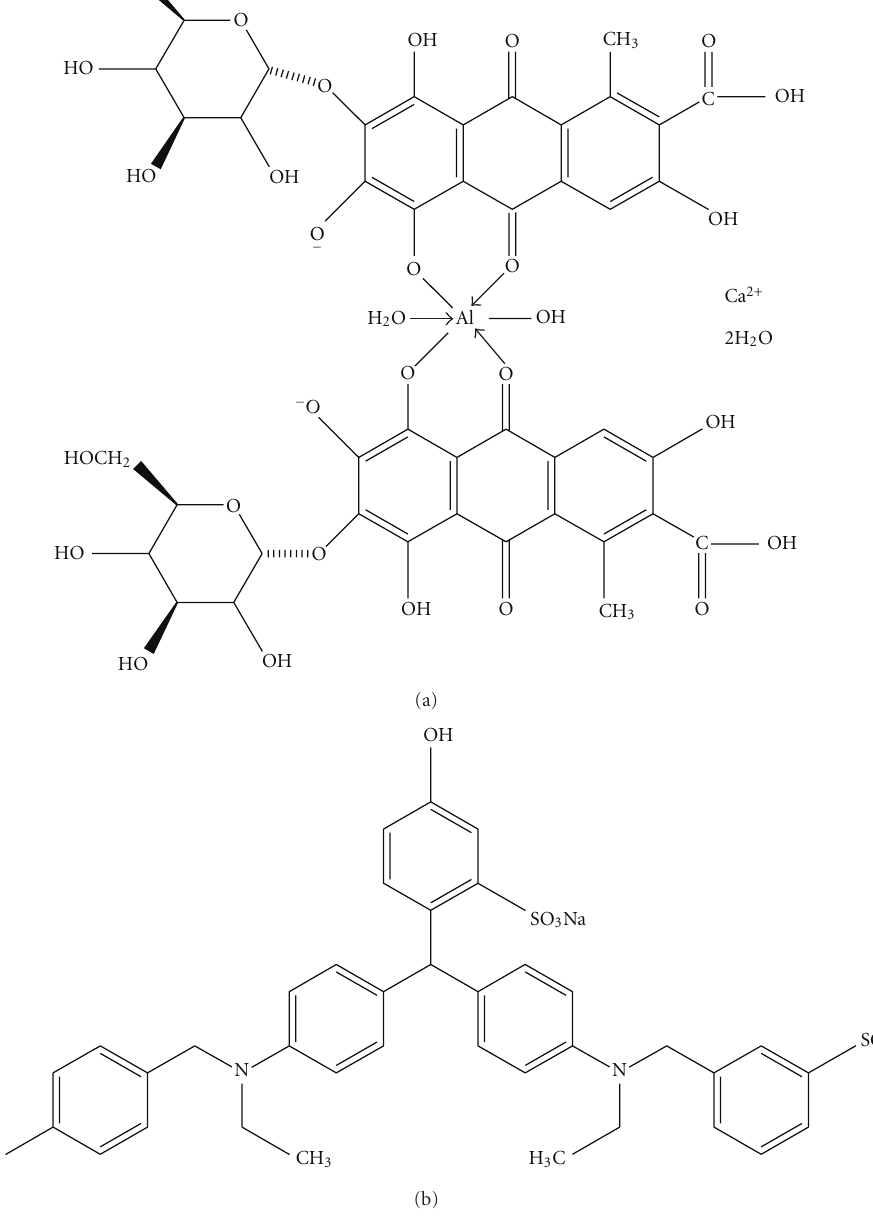
Figure 3: Structure of (a) carmine and (b) fast